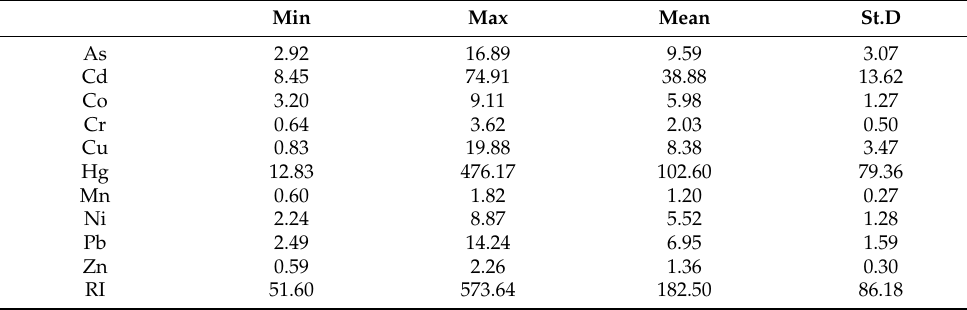
Table 6. Description of the results of the potential ecological risk index.